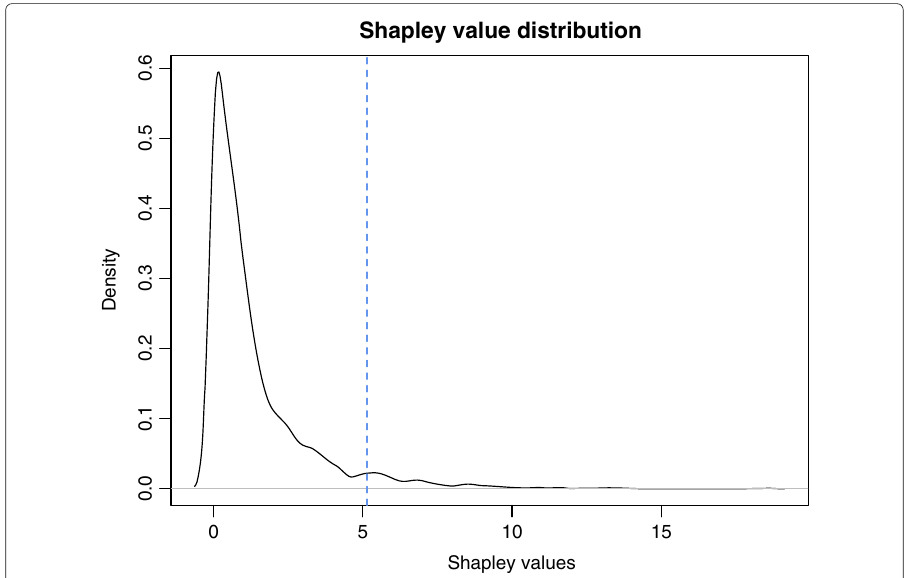
Fig. 8 Third analysis: Shapley value distribution. The density distribution of the index ρ is shown, for k i defined as the number of clusters gene i belongs to. The dotted vertical line represents the cutoff: the 5% of genes with highest index is